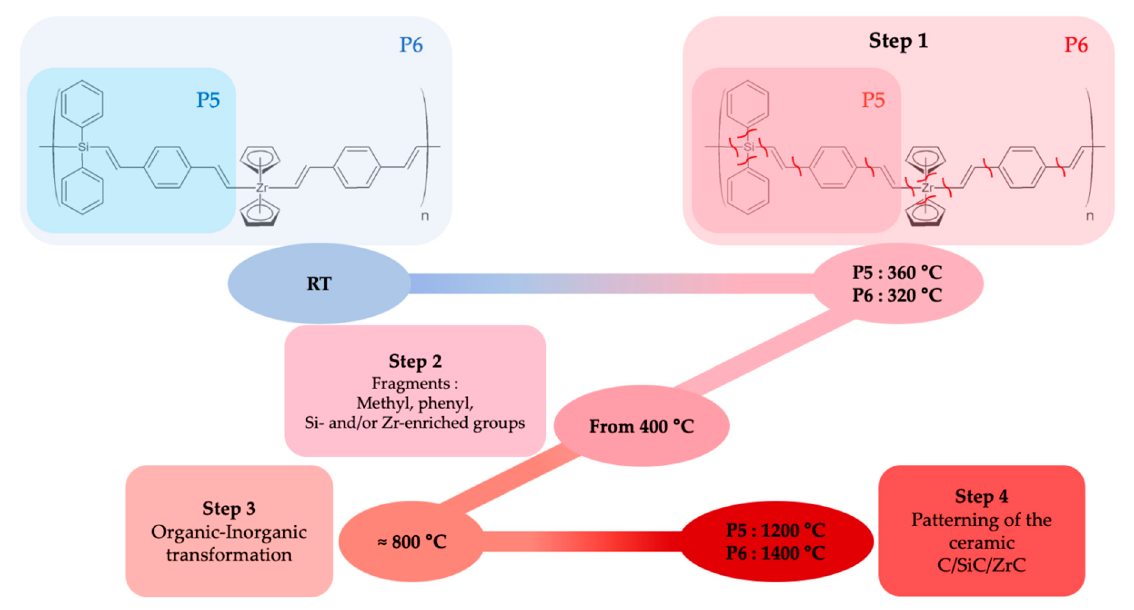
Figure 5. Schematic representation of the ceramisation mechanism of l -hPCS and l